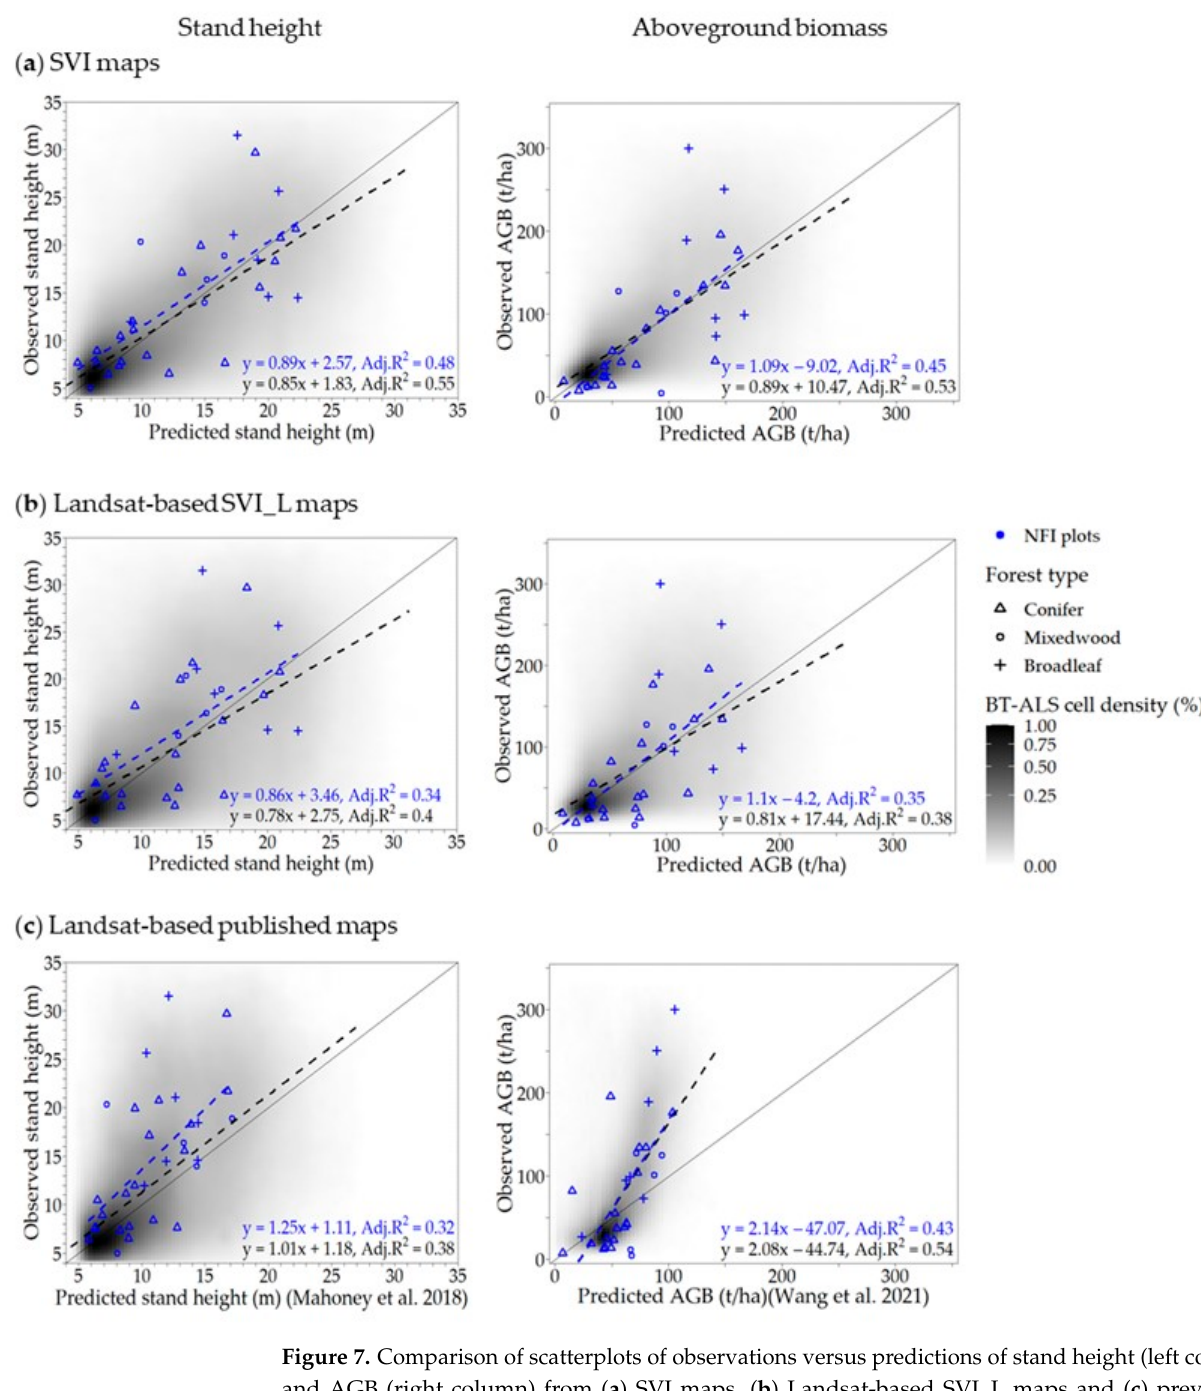
Figure 7. Comparison of scatterplots of observations versus predictions of stand height (left column) and AGB (right column) from ( a ) SVI maps, ( b ) Landsat-based SVI_L maps and ( c ) previously published Landsat-based maps using all NFI plots (blue dots) and BT − ALS LiDAR plots (density scatterplot). Dashed blue and black lines are regression lines along with equations and adj. R 2 values, respectively, based on NFI plots and BT − ALS LiDAR plots (see Table S3 for linear regression statistics of all attributes). Distinctive symbols for the NFI plots (blue dots) distinguish the three forest cover types.